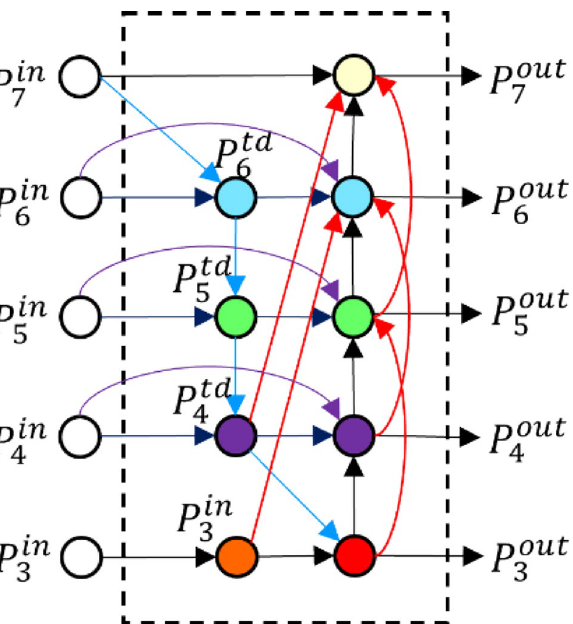
Figure 5. Bi-FPN module improved in this